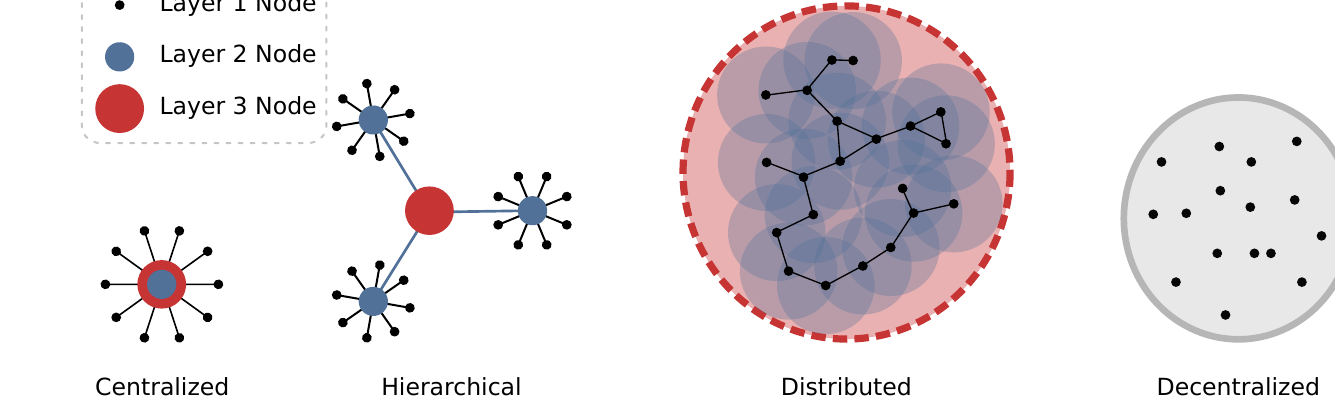
Figure 7. Representation of the different information